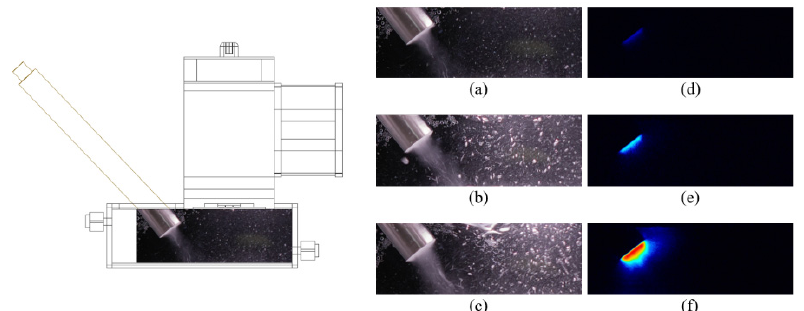
Figure 1. Mapping the ultrasound characteristics applied by a tip-sonotrode in water. Bubble-field formation for the amplitudes 38.25, 76.5, and 114.75 µm ( a – c ) with generated mixing zones and cavitation zones generating OH radicals visualized by chemiluminescence for the amplitudes 38.25, 76.5, and 114.75 µm ( d – f ).